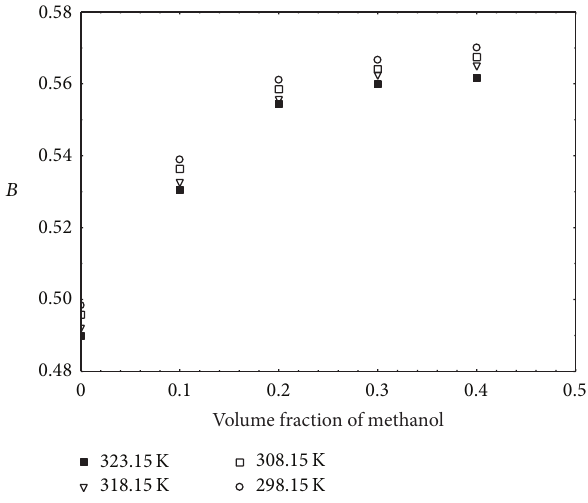
Figure 10: Variation of viscosity 𝐵 coefficients of CTAB solutions with volume fraction of